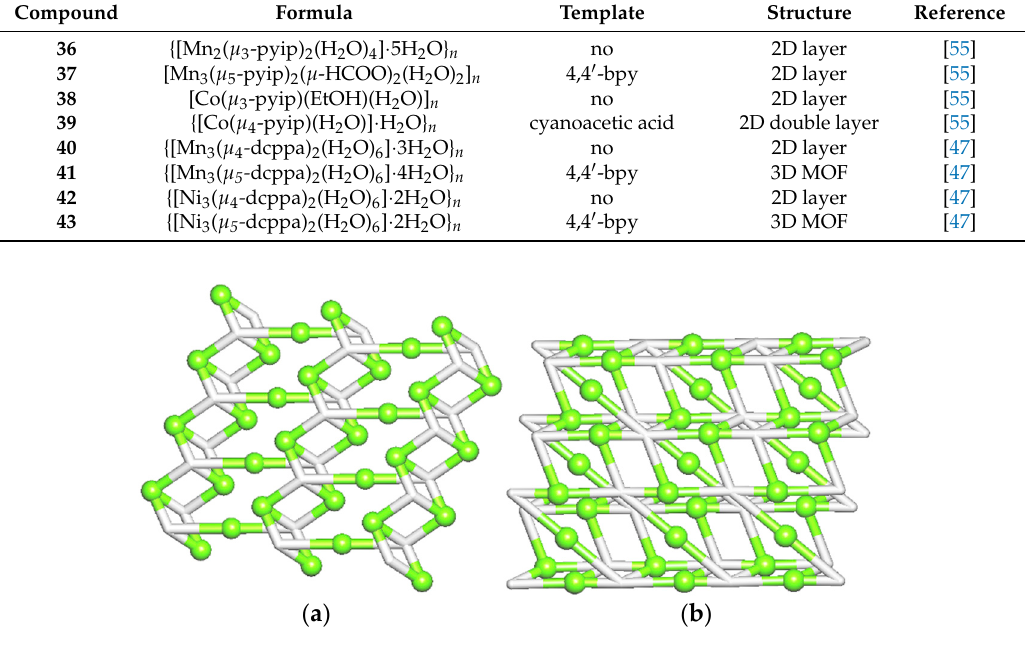
Figure 8. Topological representation of underlying nets: ( a ) 2D layer with 3,4L83 topology in 42 ; ( b ) 3D framework with tcs topology in 43 . Adapted from [47].